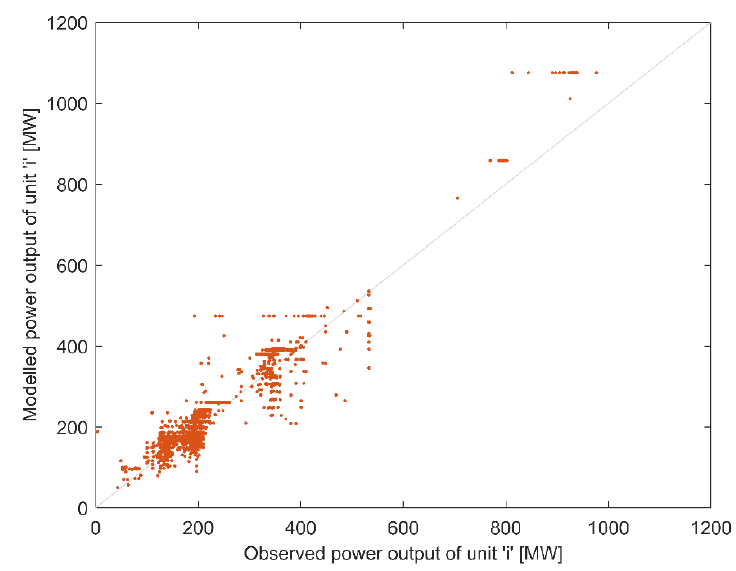
Figure 4. Modeled and observed unit dispatch (MW) in the period between 13:00 and 14:00 in June 2018.